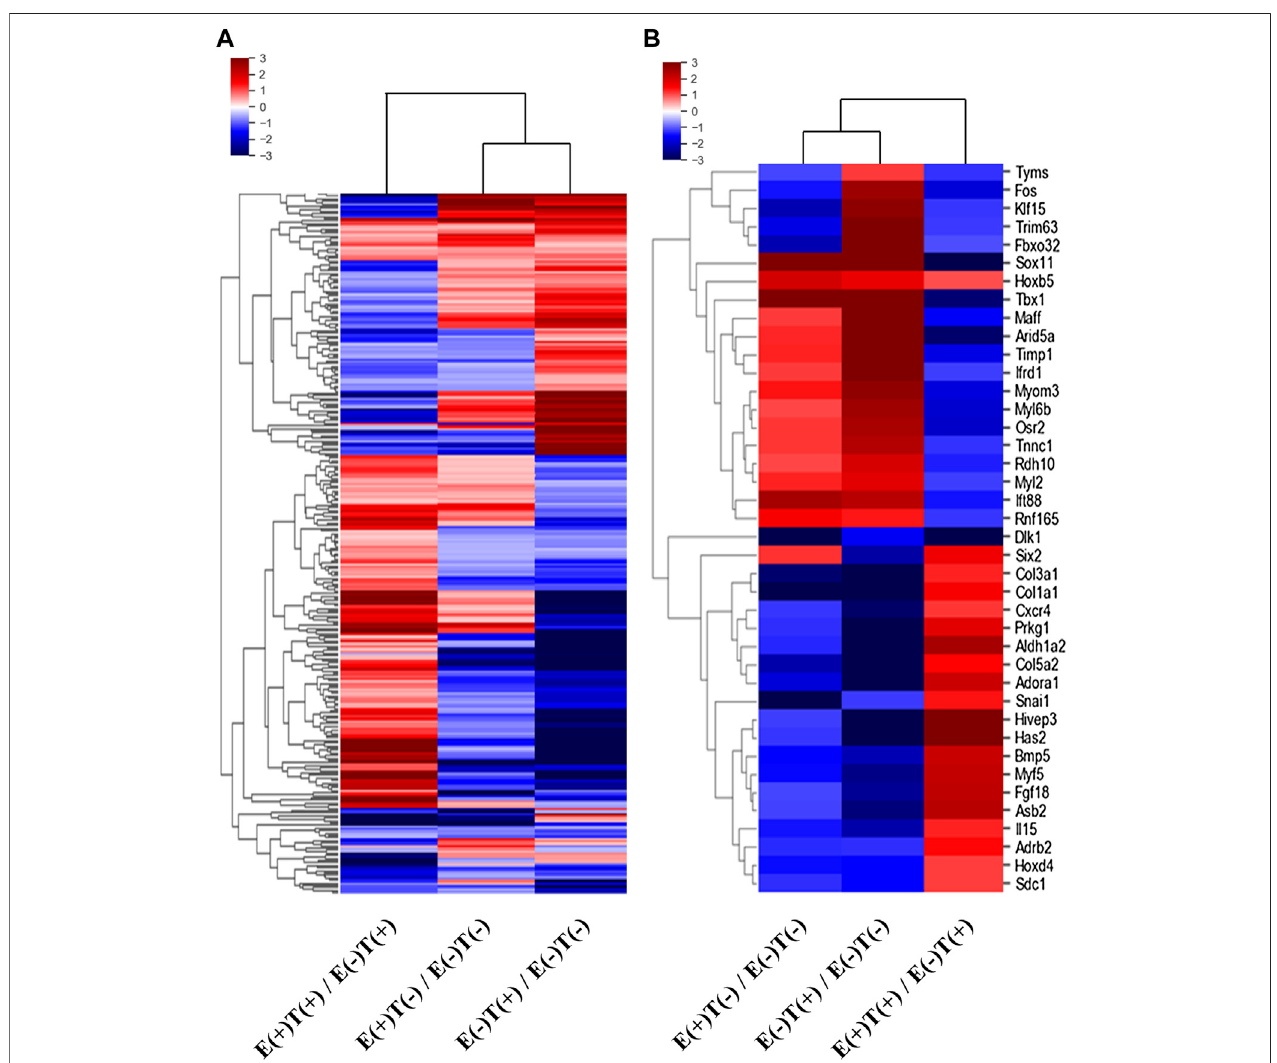
FIGURE 2 | Heatmaps of DEGs of skeletal muscle-related genes. The differentially expressed skeletal muscle-related genes were selected according to the fold changes and normalized read counts from the output of mRNA-seq of skeletal muscles (gastrocnemius muscle). E, exercise; T, tumor injection; (+), execution; ( − ), non- execution. (A) A heatmap of top 285 DEGs (at least 1.25-fold change in expression in any one of the three-way comparisons shown) from 998 skeletal muscle-related genes. (B) A heatmap of top 40 DEGs (at least two-fold change in expression in all three-way comparisons) from 998 skeletal muscle-related genes. Remarkably different expressional patterns of the gastrocnemius muscle-derived genes are